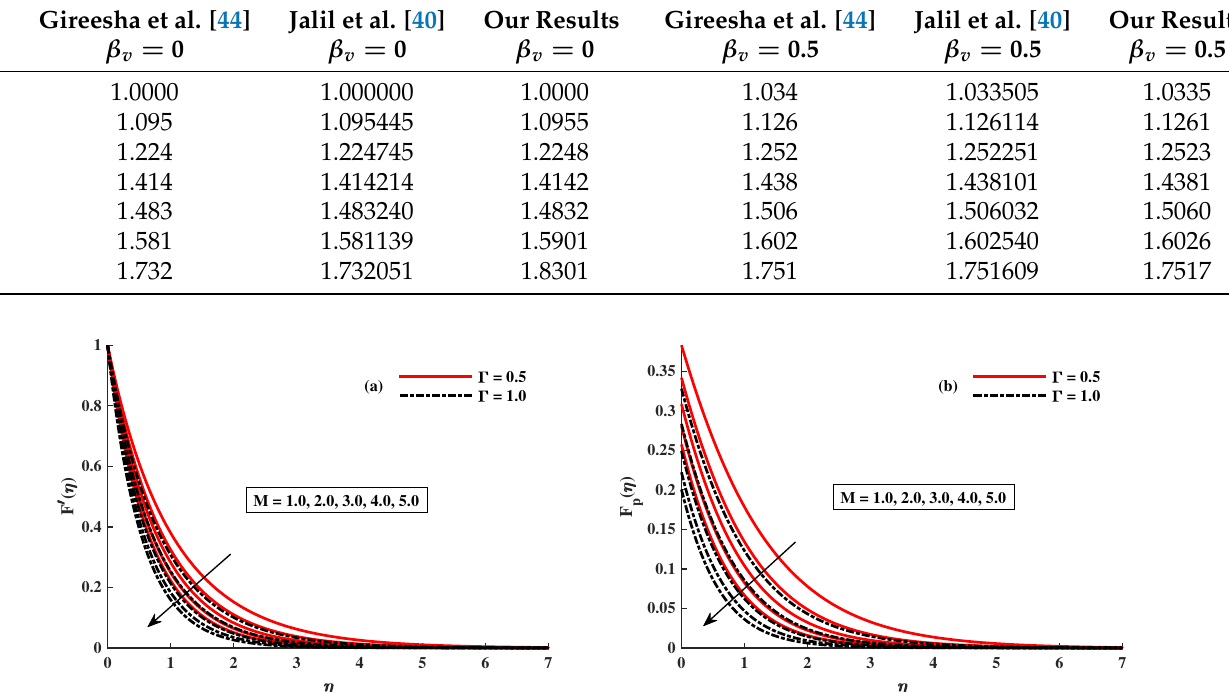
Figure 2. Variation of M to influence the fluid and dust velocity